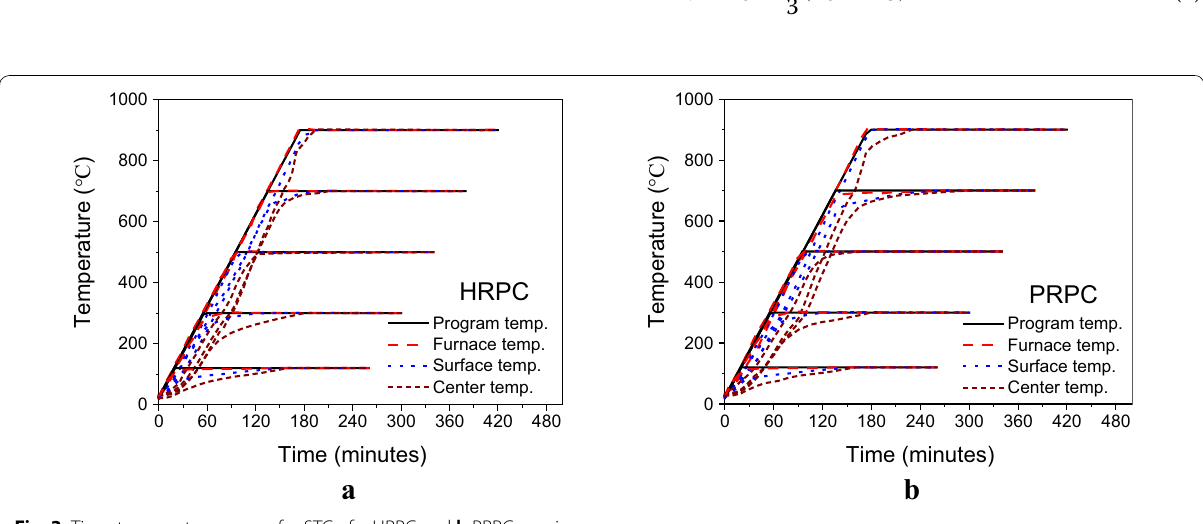
Fig. 3 Time-temperature curves for STC of a HRPC and b PRPC